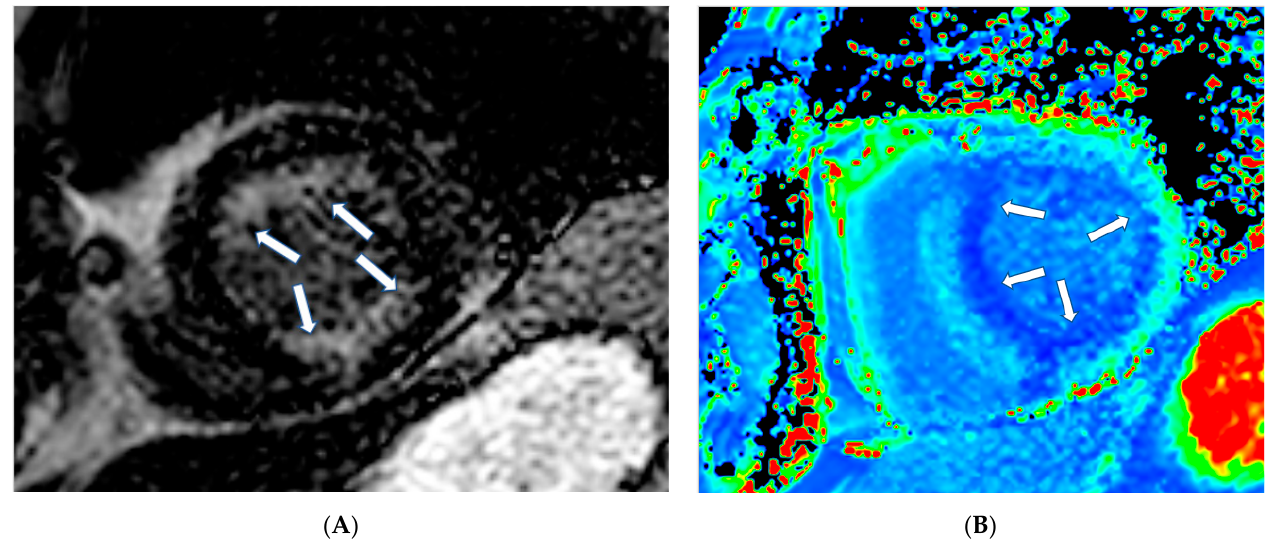
Figure 5. ( A ) Short axis LGE image showing diffuse amyloidosis (arrows). ( B ) Matching native T1 mapping of the same patient.